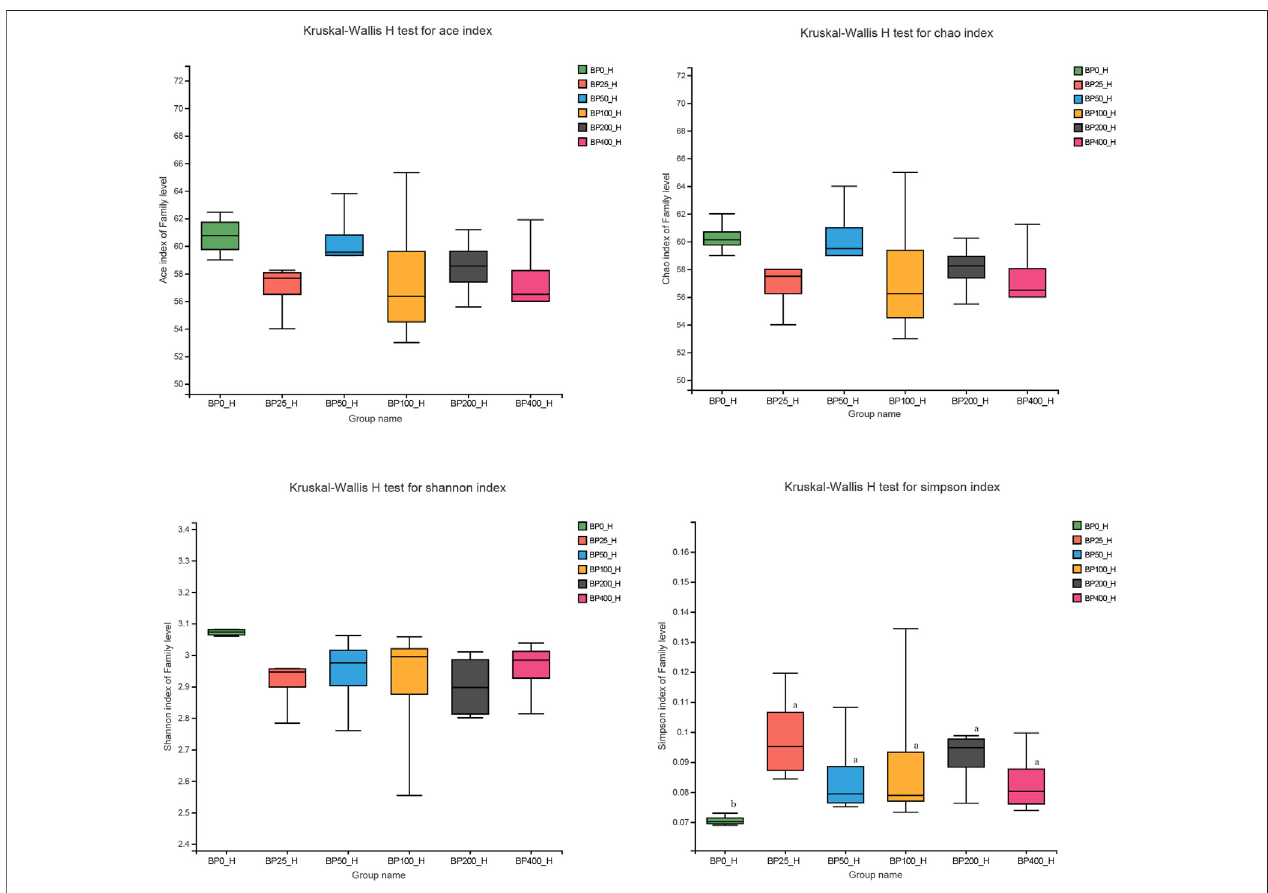
FIGURE 3 | Alpha diversity analysis in